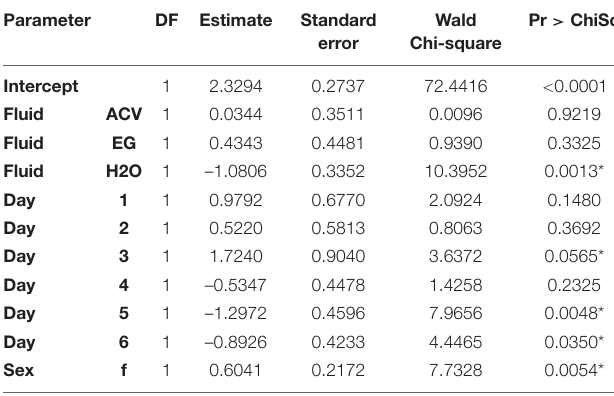
TABLE 11 | Type 3 analysis of effects of flies from Sandhills Research Station blueberry